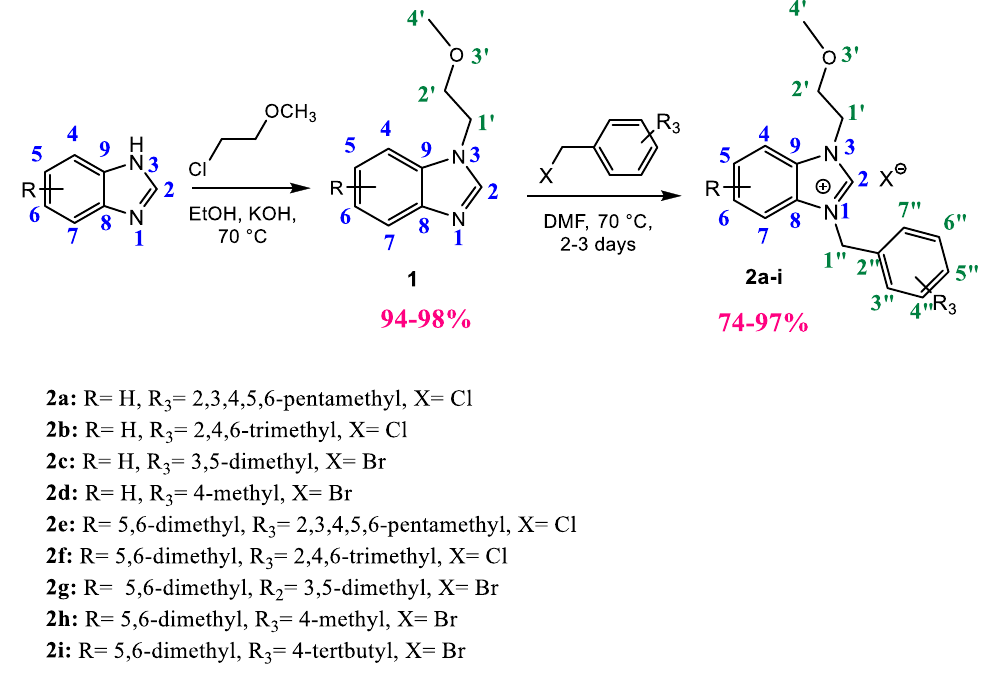
Scheme 1. Protocol synthesis of benzimidazolium salts 2a–2i